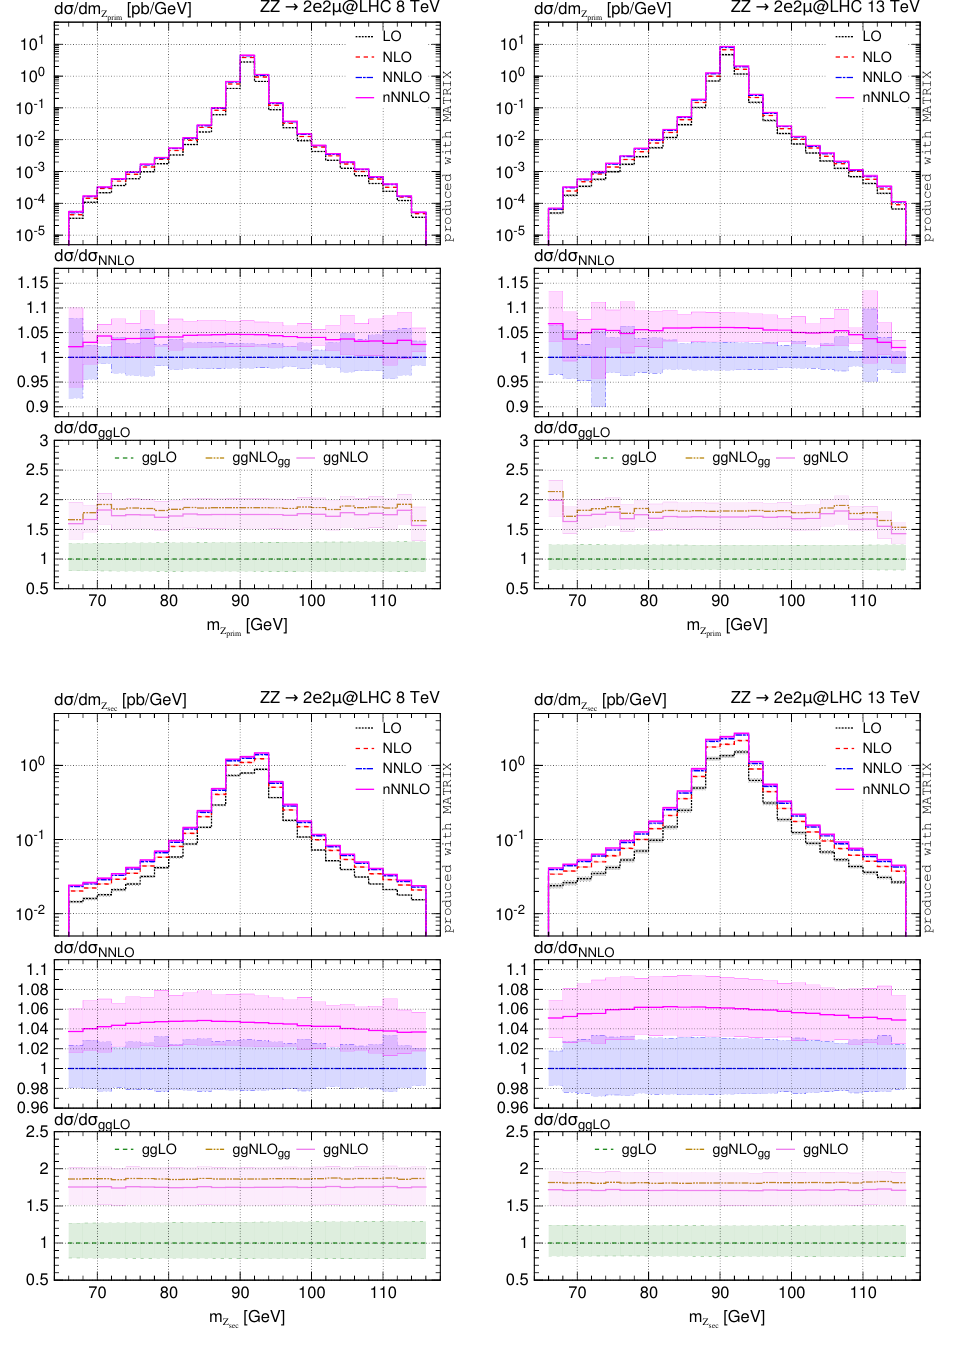
Figure 5 . Invariant-mass distribution of the OSSF lepton pair closer to (top) and further away from (bottom) the Z -boson mass at 8 TeV (left) and 13 TeV